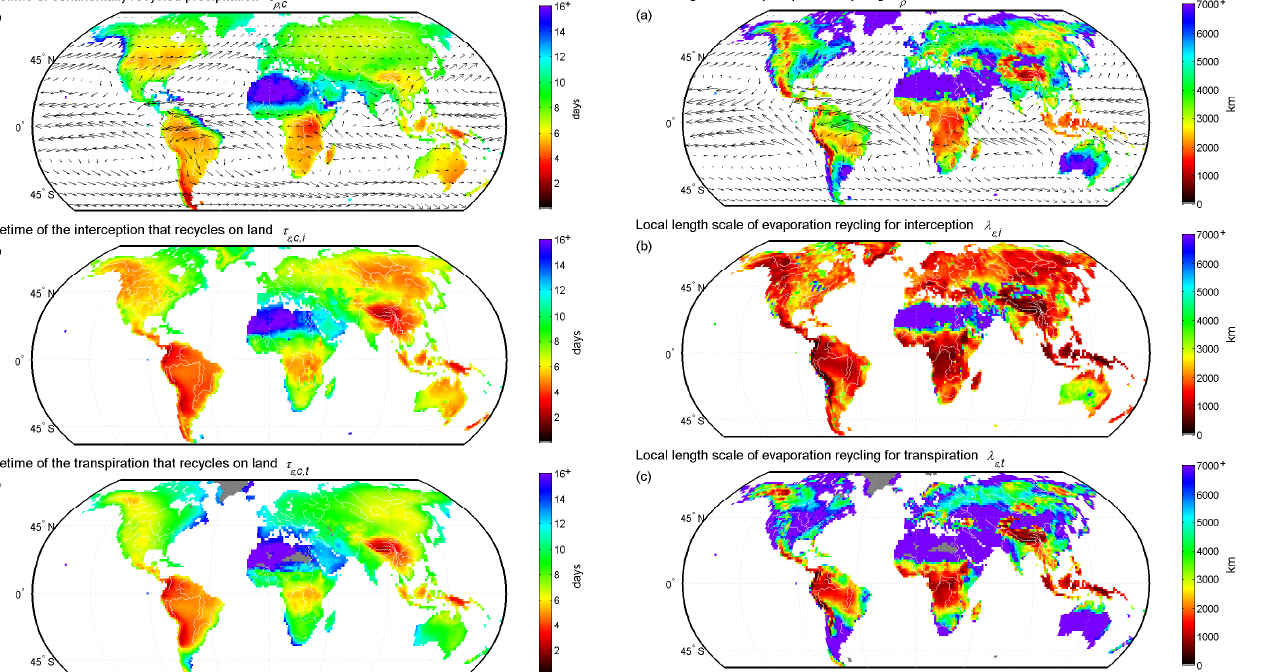
Figure 4. Average atmospheric lifetimes of recycled moisture (1999–2008). (a) Lifetime of continentally recycled precipitation τ ρ, c (defined at the point of precipitation), (b) lifetime of the inter- ception that recycles on land τ ε, c,i (defined at the point of evapora- tion), and (c) lifetime of the transpiration that recycles on land τ ε, c,t (defined at the point of evaporation). Grey values on land indicate no data, due to the fact that the evaporative flux in question is 0. The arrows in (a) indicate the vertically integrated moisture fluxes.